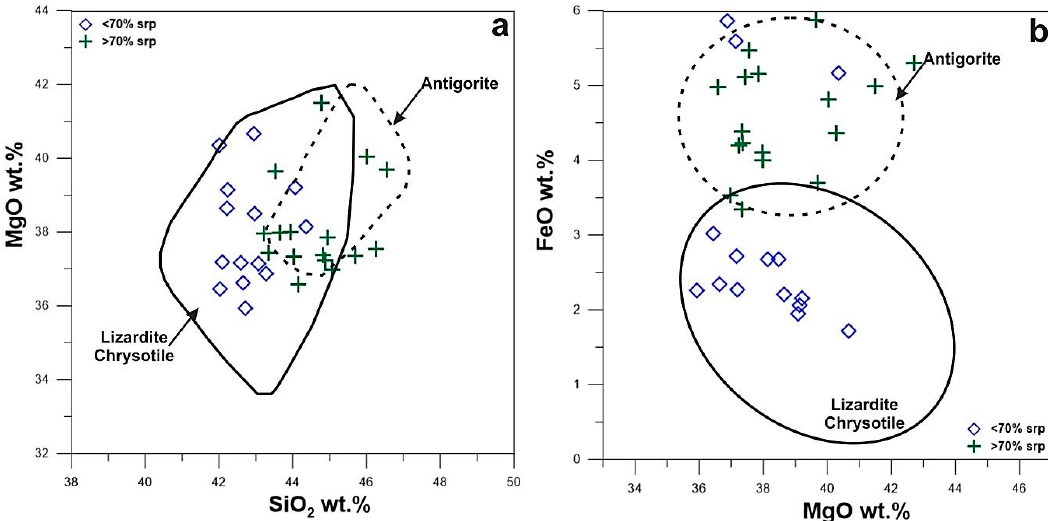
Figure 7. ( a ) MgO versus SiO 2 plot and ( b ) FeO versus MgO plot for the analyzed serpentine minerals in examined serpentinized ultramafic. Fields of antigorite, lizardite and chrysotile are from Singh and Singh [27].